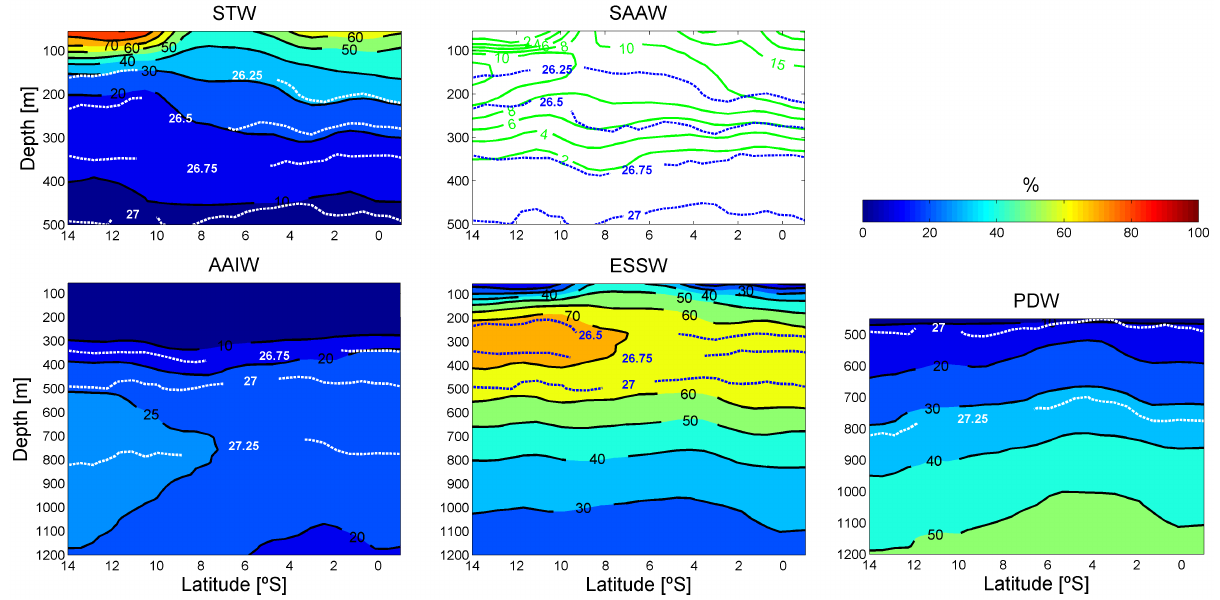
Fig. 2b. Water mass distribution (%) along the 85 ◦ 50 0 W section between 14 ◦ S and 1 ◦ N for the P19 cruise (March 1993), for subtropical water (STW), subantarctic water (SAAW), antarctic intermediate water (AAIW), equatorial subsurface water (ESSW) and pacific deep water (PDW) as defined in Table 1. Selected isopycnals are shown as dotted white/blue